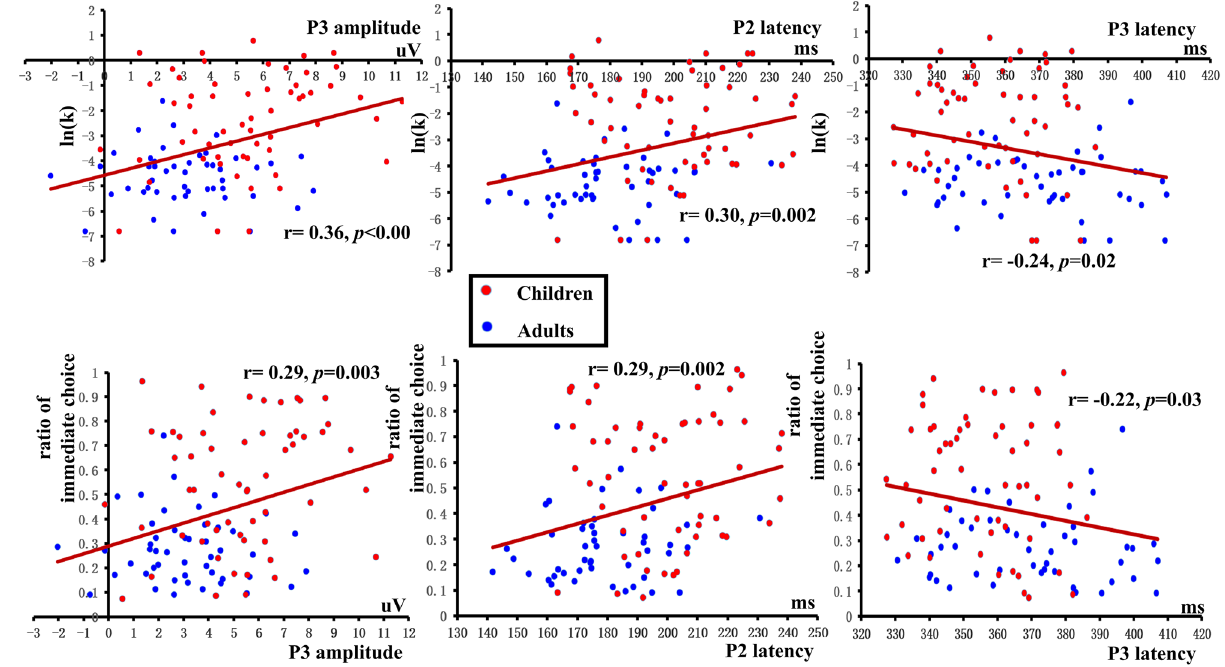
Figure 5. The correlations of ln(k)(the top row)/ ratio (the bottom row) and P2 latencies, P3 amplitudes and latencies in the whole group. The picture was created by Microsoft Excel 2016 MSO (16.0.13628.20234) 64 bits (https:// www. micro soft. com/ zh- cn/ micro soft- 365/ excel) and Microsoft PowerPoint 2016 MSO (16.0.13628.20234) 64 bits (https:// www. micro soft. com/ zh- cn/ micro soft- 365/ power